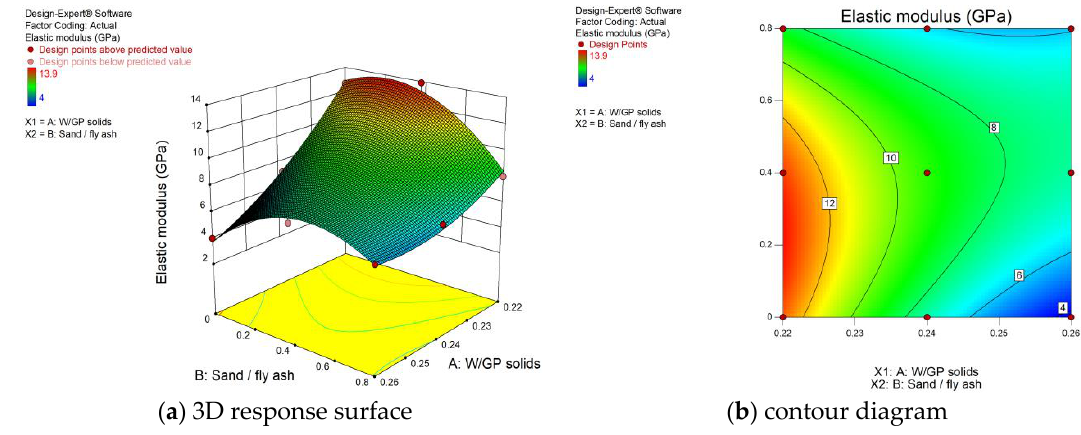
Figure 6. Elastic modulus versus W/GP solids and sand/fly ash. ( a ) 3D response surface, ( b ) contour diagram.